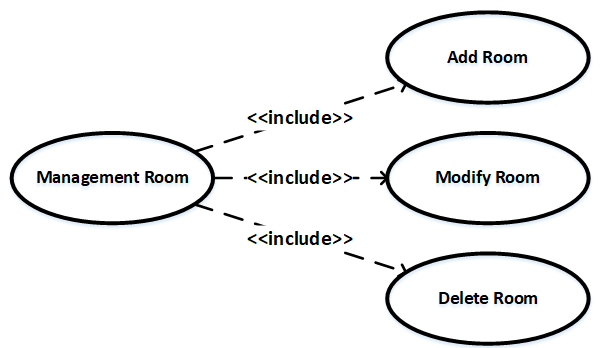
Figure 7. The include relationship between use cases.